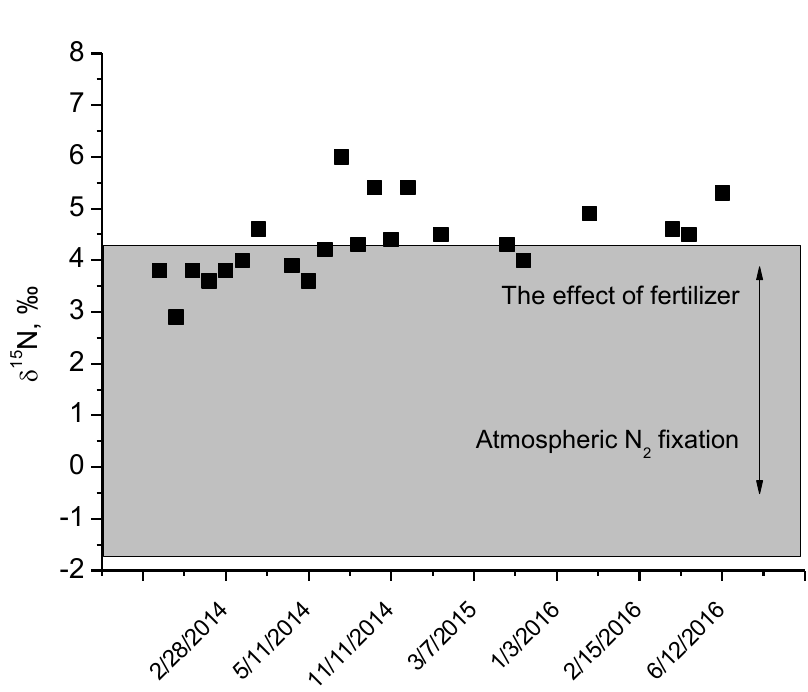
Figure 3. δ 15 N values in cow milk (squares). The grey shaded area represents the measured δ 15 N values of the grass.